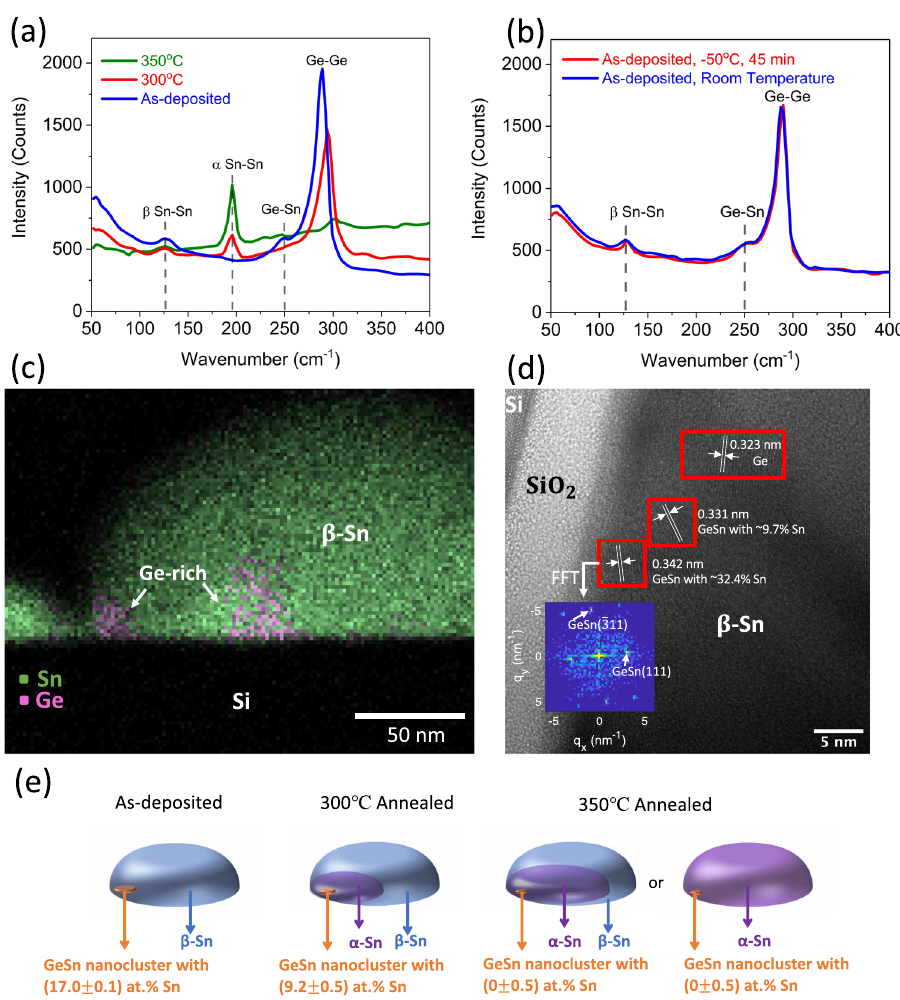
Fig. 2 Mechanism of reversed β → α -Sn transition upon RTA. a Raman spectra of as-deposited (blue) and annealed SnGe samples at 300 °C (red) and 350 °C (green) (RTA for 2 min). b Raman spectra of an as-deposited SnGe sample at room temperature (blue) and after cooling to − 50 °C for 45 min (red). c EDS mapping of the as-deposited sample, showing Ge-rich nanoclusters at the microdot/oxide interface. d HRTEM image of the as-deposited sample. Several Ge or Ge-rich GeSn nanoclusters are clearly identi fi ed, with the (111) interplanar spacing and estimated Sn compositions labeled individually. e Schematic mechanism of β → α -Sn transition upon annealing at elevated temperature. The average Sn composition in GeSn nanoclusters is derived from the Ge-Ge and/or Ge-Sn peak positions in the Raman spectra.